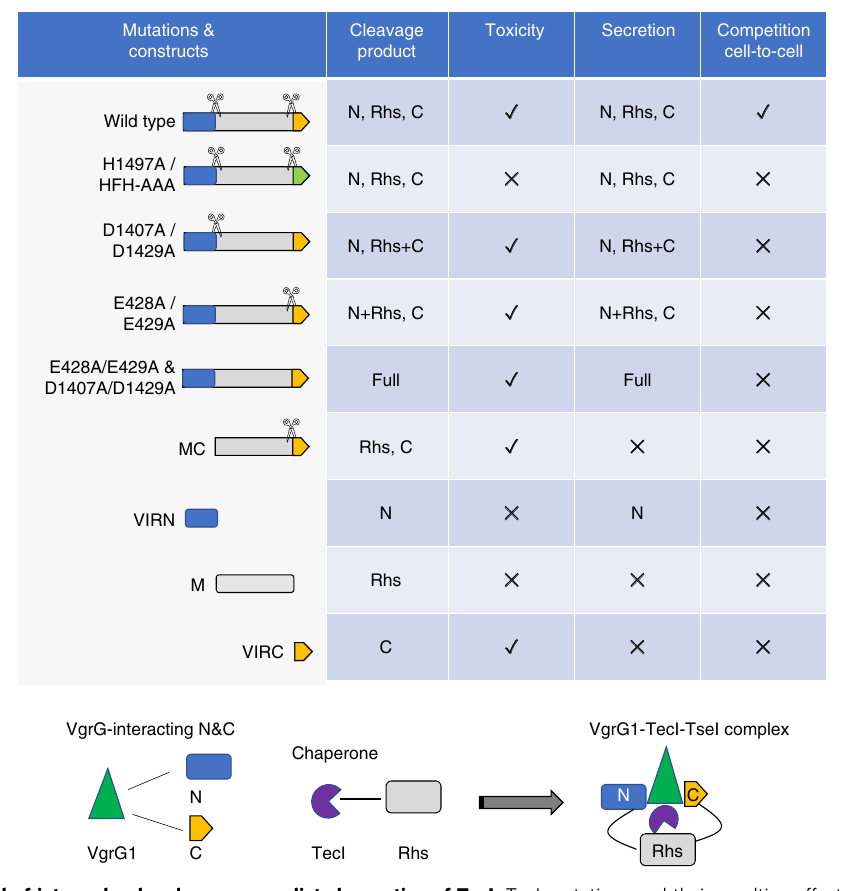
Fig. 6 A schematic model of intramolecular chaperone-mediated secretion of TseI. TseI mutations and their resulting effects are summarized. TseI is self-cleaved into three fragments. Both N- and C-terminal domains interact with VgrG, named VIRN and VIRC respectively, while the Rhs core (M) interacts with the Tec chaperone protein. It is likely that VgrG1, TecI, and TseI form a transient protein complex prior to delivery. Note that VIRN, Rhs, and VIRC likely maintain noncovalent interaction even after cleavage. VIRC secretion requires VIRN and Rhs that are also co-secreted by the T6SS. Therefore, VIRN and Rhs may serve as secreted intramolecular chaperones to facilitate VIRC speci fi c environmental signals by cleaving off the inhibitory self-cleavage of Rhs proteins as T6SS effectors, further highlight peptide 56 – 58 . Other proteases including subtilisin and alpha-lytic the versatility of T6SS delivery 38 . protease employ self-cleaved peptides to guide the folding and stability of the protease domain 59 – 61 . These cleaved fragments are named intramolecular chaperones as they are encoded in the primary gene sequences 62,63 . The self-cleaved VIRN and Rhs core thus distinguish themselves from the known T6SS chaperones 34,35 and represent a new class of intramolecular chaperone for toxin secretion. These fi ndings, together with the